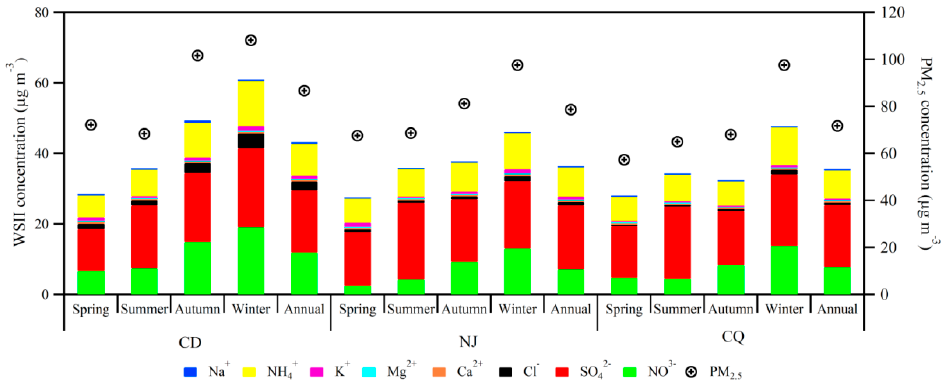
Figure 2. Seasonal variations of PM 2.5 and WSIIs in CD, NJ, and CQ.